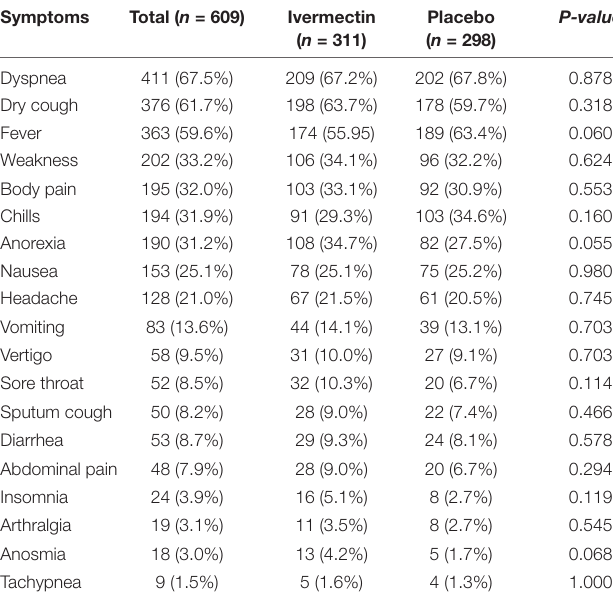
TABLE 2 | Symptoms of inpatients in the first day of